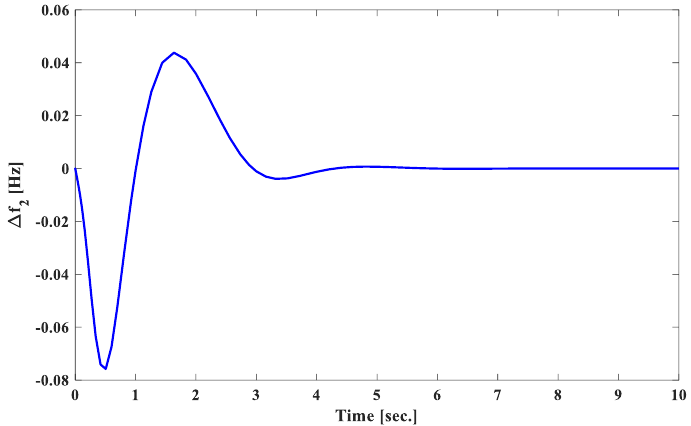
Figure 20. Frequency [Hz] of control area 1 under matched disturbances.